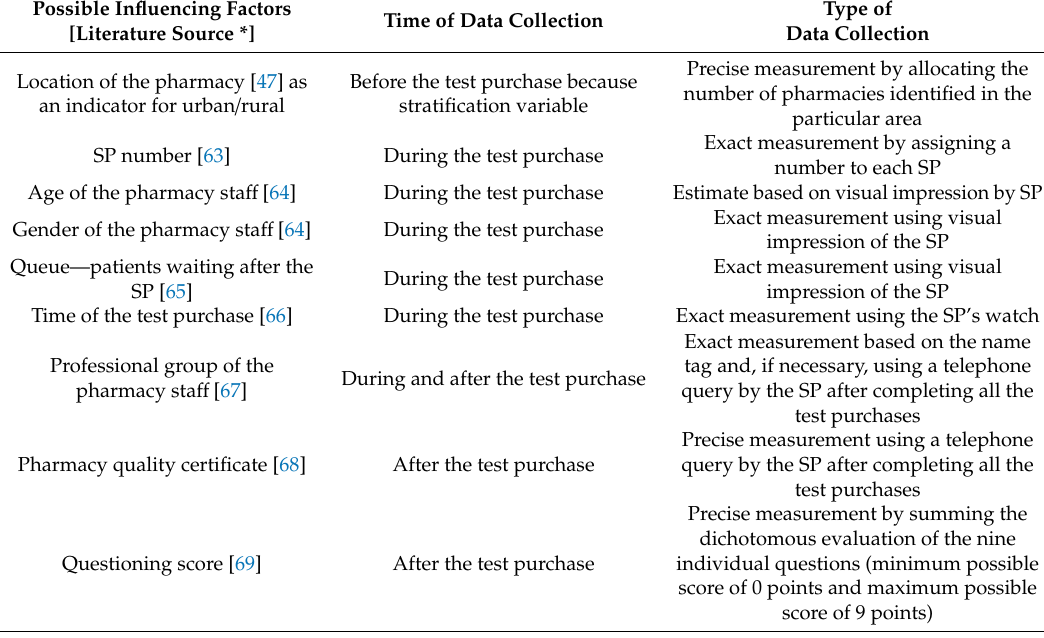
Table 3. Possible influencing factors as well as time and type of data